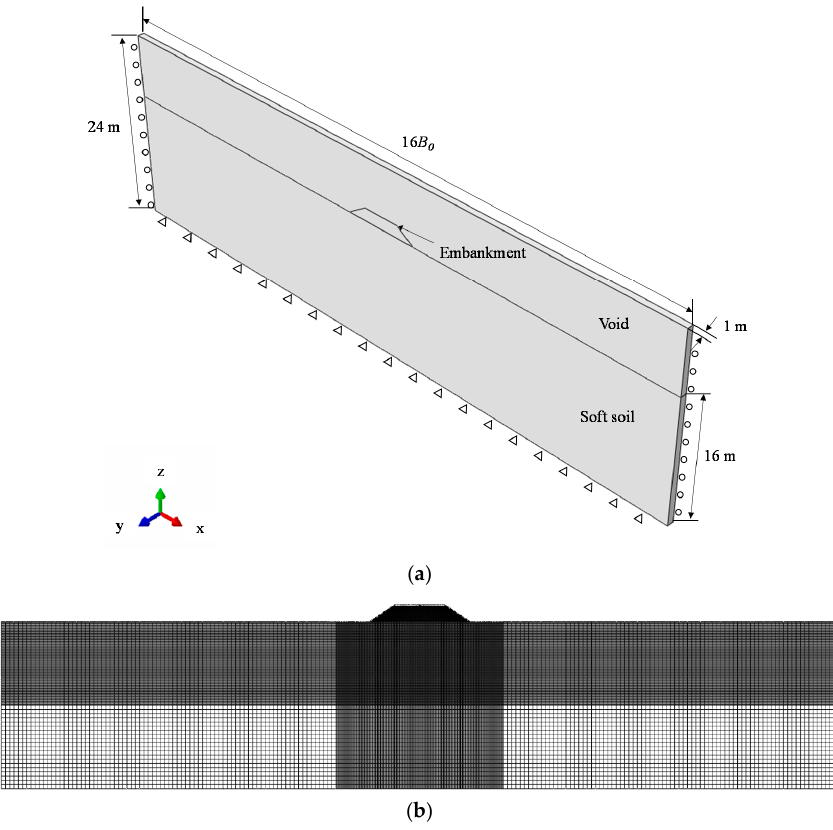
Figure 8. CEL model for the simulation of forced replacement method: ( a ) Dimensions and boundary conditions; ( b ) typical mesh.